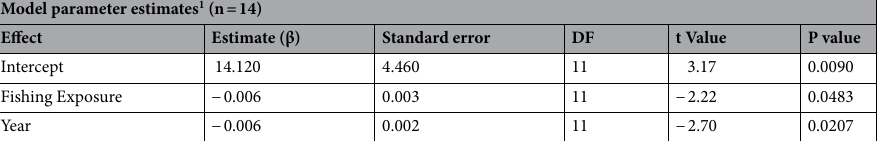
Table 2. Association between Shannon H-index and fishing exposure level. 1 SAS PROC GLIMMIX (version 9.4, Cary, N.C.) was employed to assess associations, using an inverse gaussian distribution and a log link function. Fishing exposure was measured on an ordinal scale delineated as 0 (none), 1 (low), 2 (moderate). DF degrees of